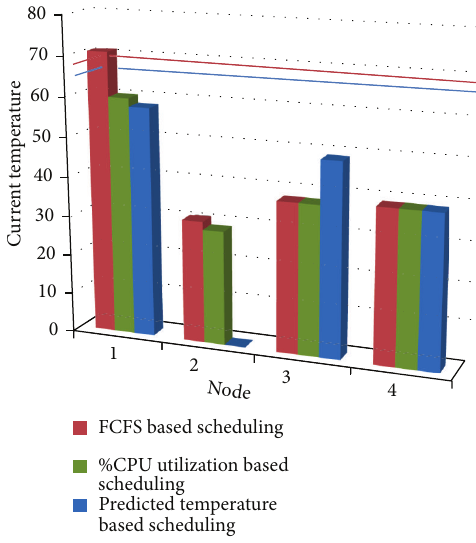
Figure 5: Comparison of FCFS, %CPU Utilization, and predicted temperature based scheduling for Scenario